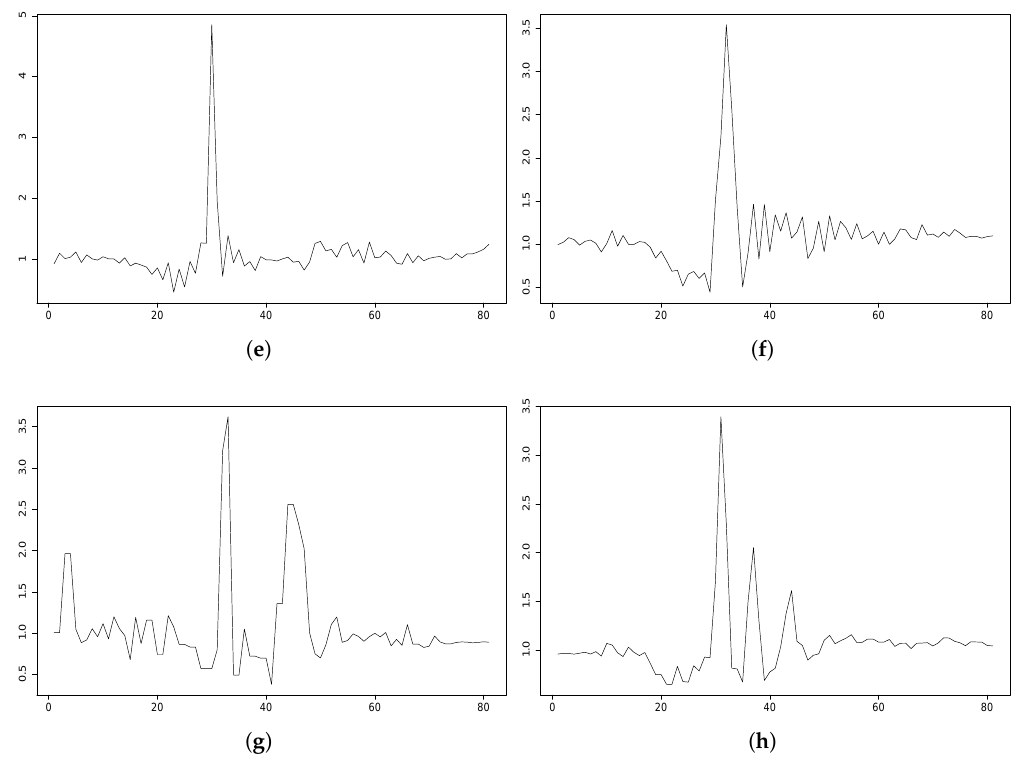
Figure 7. UMA Fall plots for some fall events from participants behaving as expected. The plots depict the magnitude of the acceleration during a fall in a period of 4 s (80 samples). The data come from the 3DACC sensor on the waist. ( a ) P1: backward fall, 3DACC ∈ [ 0.0,4.0 ] × g . ( b ) P1: backward fall, 3DACC ∈ [ 0.0,8.0 ] × g . ( c ) P2: lateral fall, 3DACC ∈ [ 0.0,5.5 ] × g . ( d ) P2: forward fall, 3DACC ∈ [ 0.0,4.1 ] × g . ( e ) P5: backward fall, 3DACC ∈ [ 0.0,5.0 ] × g . ( f ) P5: